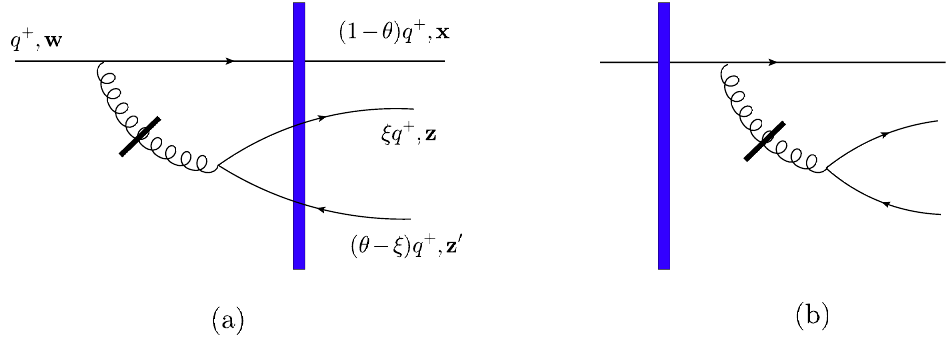
Figure 5 . The two possible insertions of the shockwave in the case where the final quark antiquark pair has been produced via an instantaneous gluon interaction: (a) initial-state evolution, (b) final- state